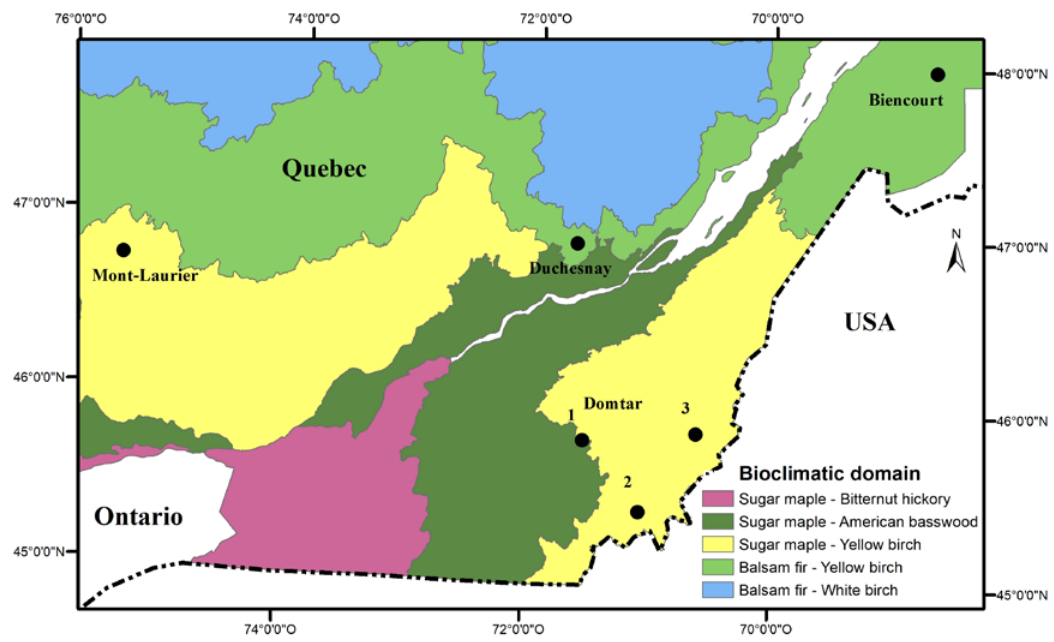
Figure 1. Locations of the six study sites in northern hardwood forests of Quebec.